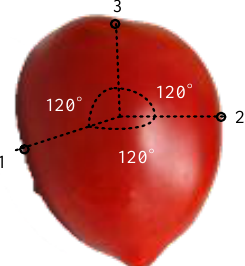
Figure 10. The three data collection points of the cherry tomato ( 1, 2, 3 are the data collection points).